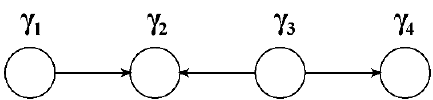
Figure 9. A BPS quiver for ( A 1 ; A 4 ) Argyres-Douglas